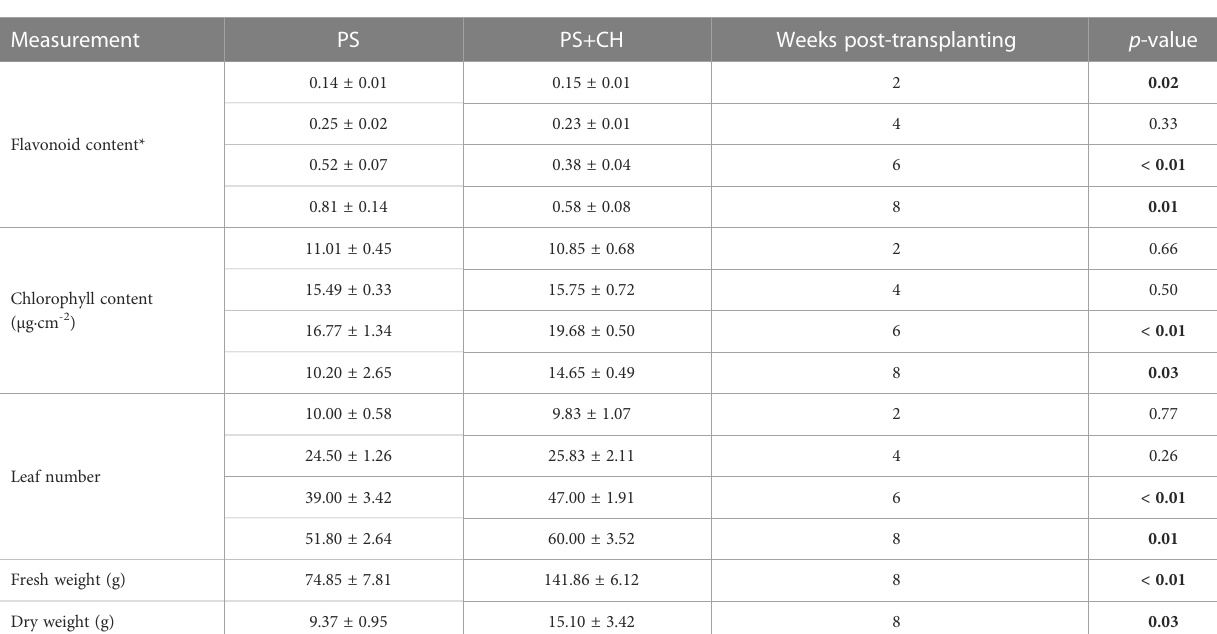
TABLE 1 Overview of the physiological parameters measured every two weeks post ‐ transplanting (wpt) for lettuce plants in chitin-amended potting soil (PS+CH) and in non-treated potting soil as control (PS). Measurement PS PS+CH